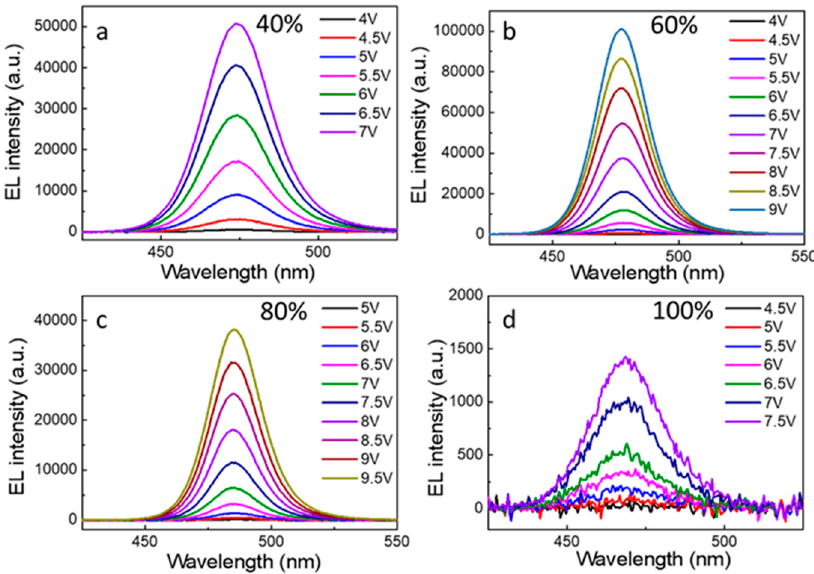
Figure 6. EL spectra of PeLEDs with ( a ) 40%, ( b ) 60%, ( c ) 80% and ( d ) 100% ratios of